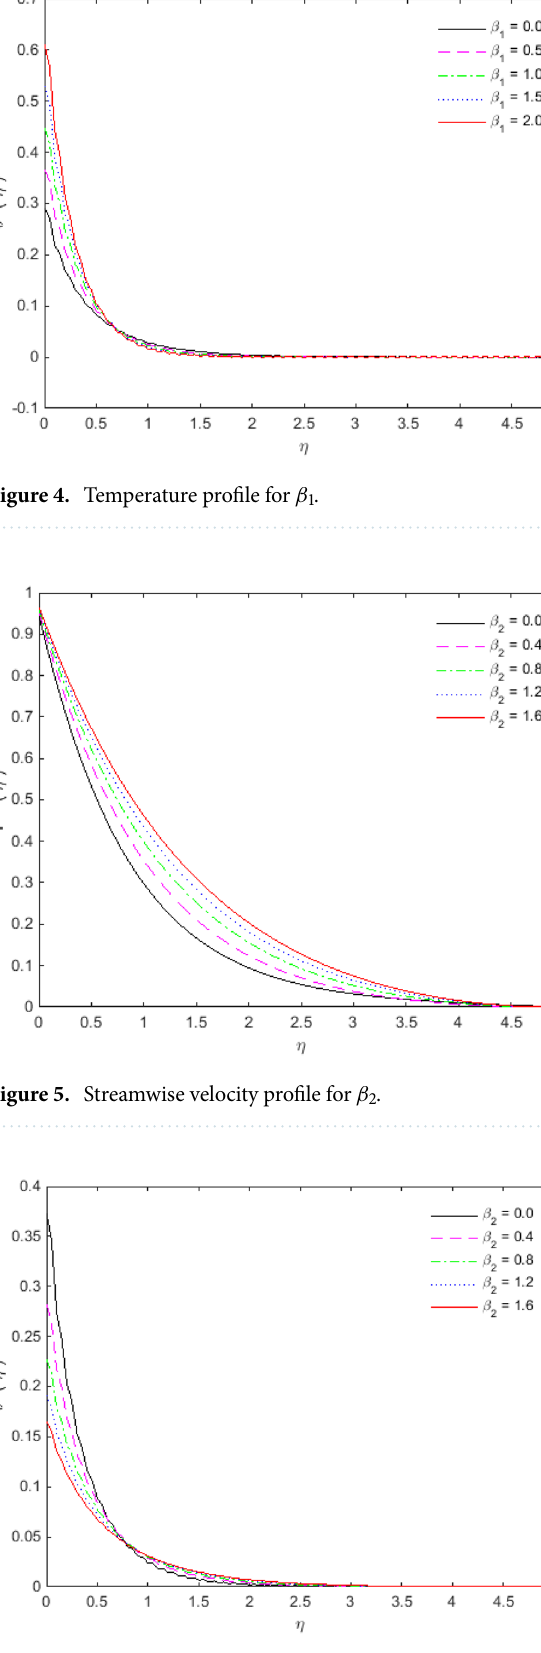
Figure 6. Temperature profile for β 2